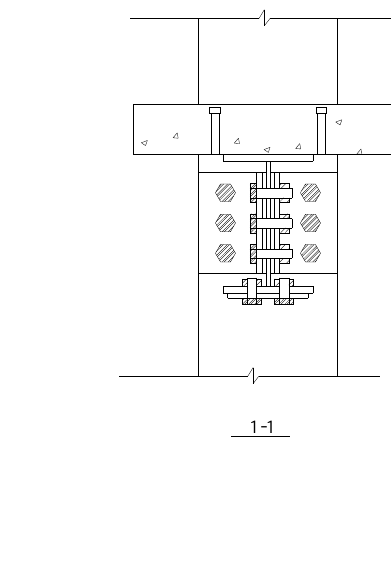
Figure 19. Model M0-RS2: connection region.